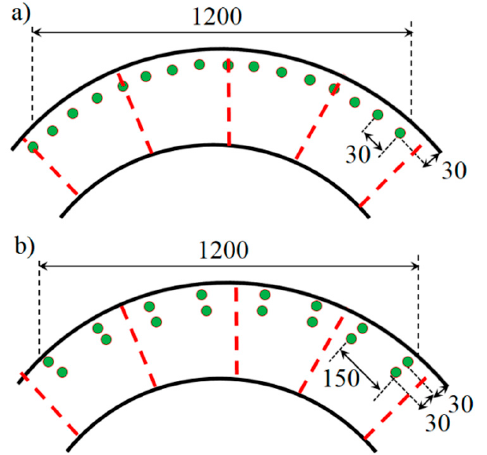
Figure 2. The arrangement pattern of simulated trees: ( a ) single row of trees (SR) Model and ( b ) double row of trees (DR) model, (not in scale, dimensions in mm, the red dashed lines are the velocity measurement sections).